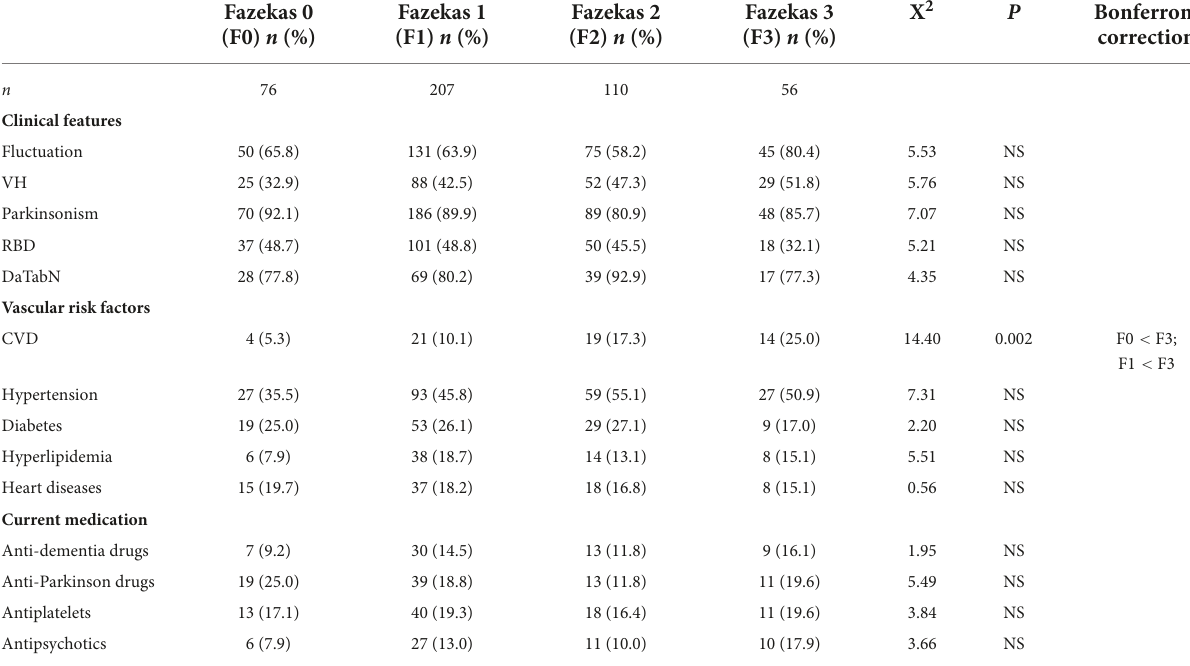
TABLE 2 Comparison of clinical features, vascular risk factors, and current medication usage among different Fazekas